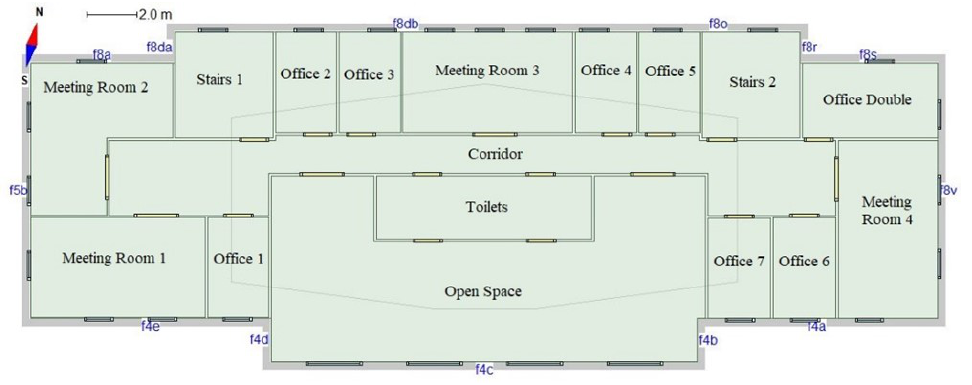
Figure 1. Typical floor